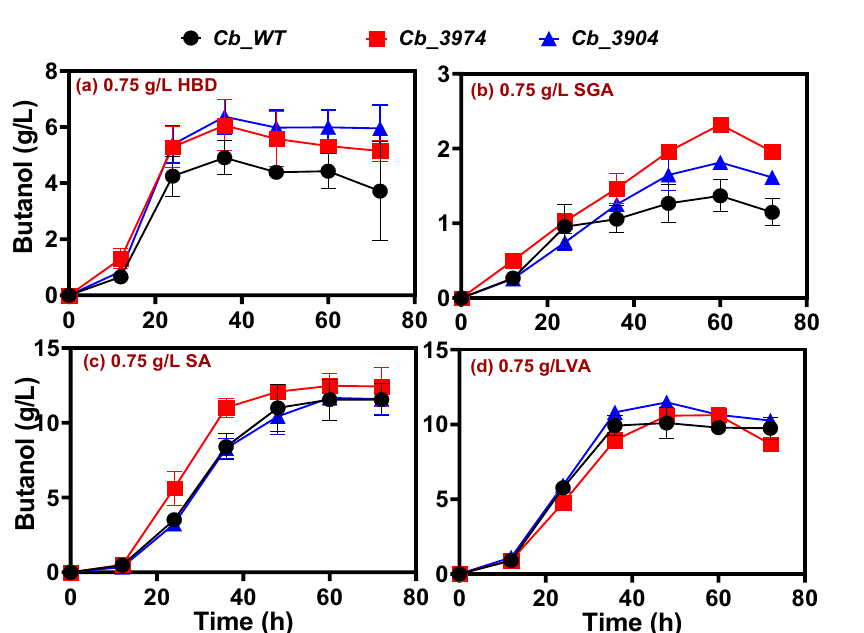
Figure 8. Butanol concentrations produced by Cb _3974, _3904, and _wild type during ABE fermentation in cultures supplemented with 0.75 g/L 4-hydroxybenzaldehyde (4-HBD), syringaldehyde (SGA), syringic acid (SA), and vanillic acid